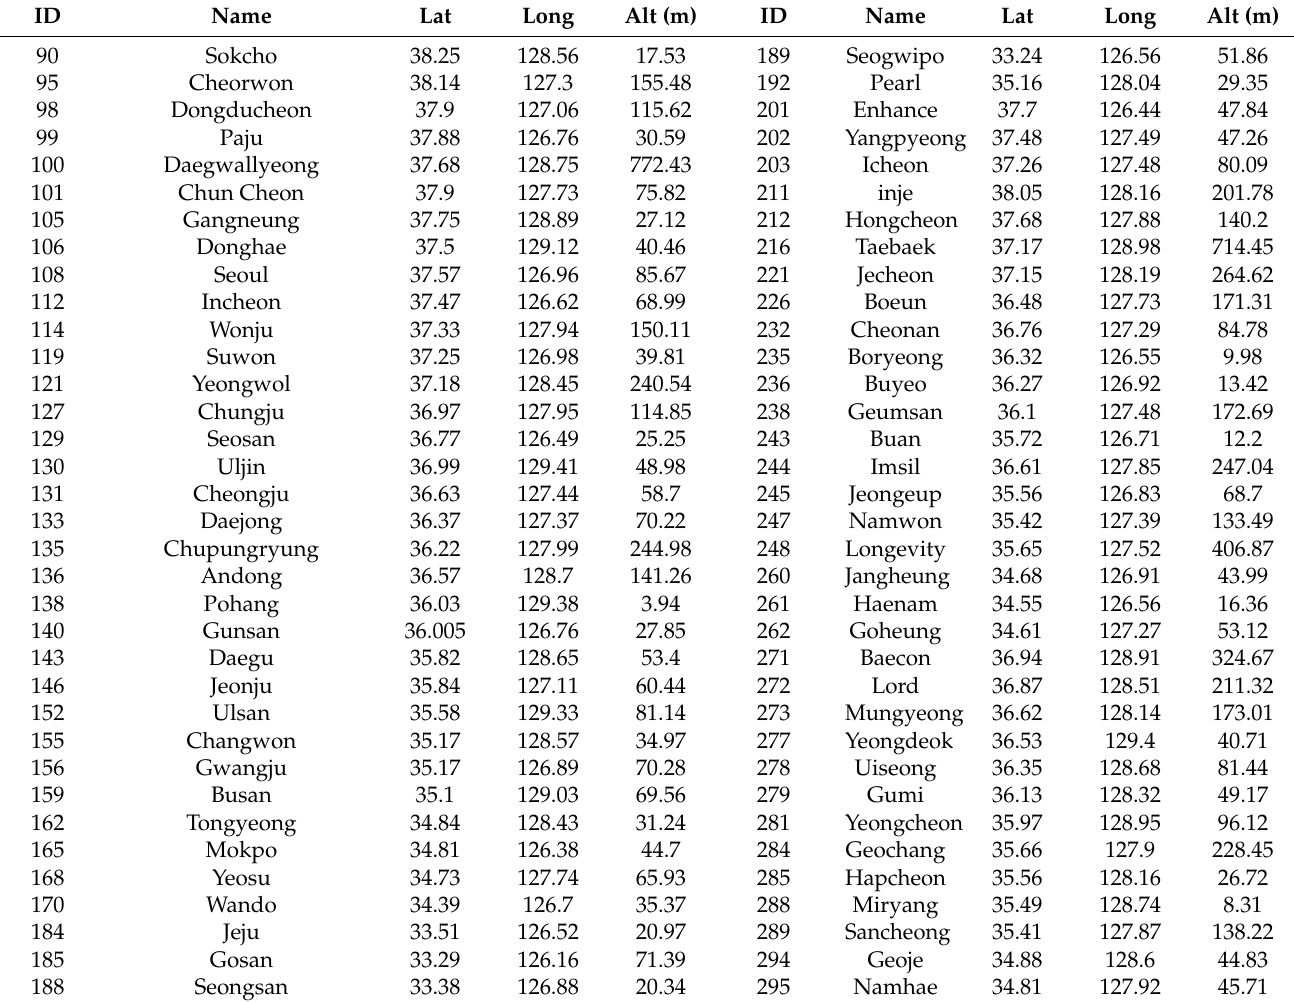
Table 2. Detail of Meteorological Stations in the Study